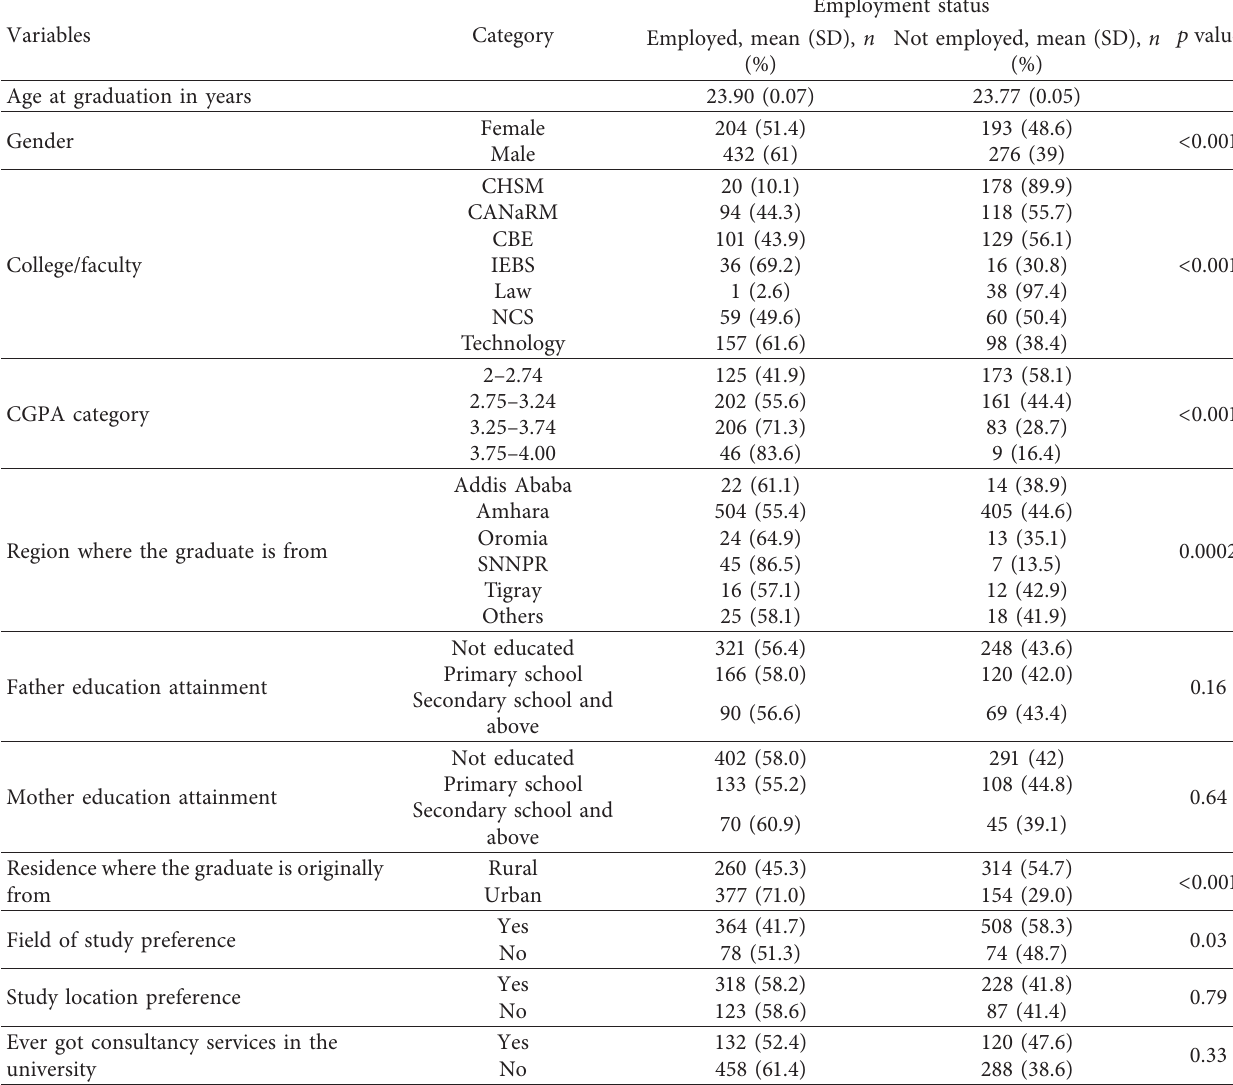
Table 1: Debre Markos University graduates’ employment status by their characteristics and the p values for the log-rank test of equality of survivor